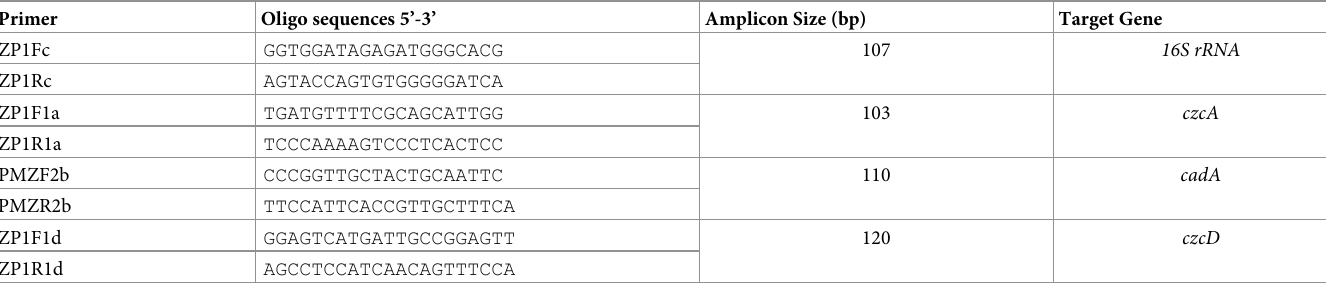
Table 1. List of primers for qRT-PCR studies.